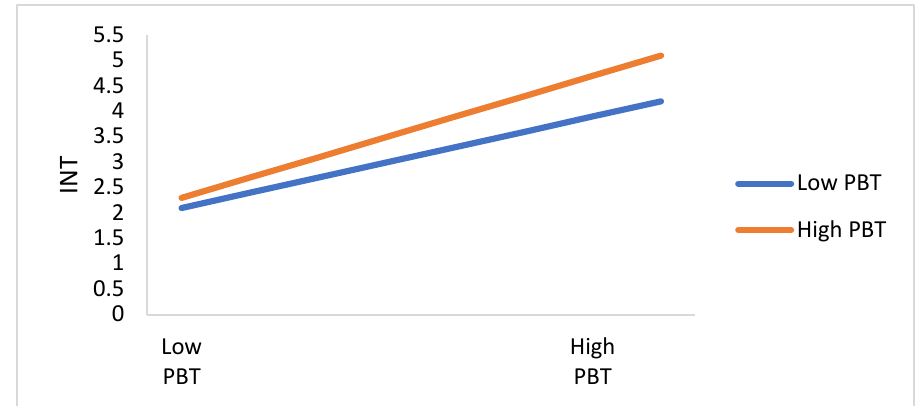
Figure 8. The plot of the moderating effect of health infodemics on the relationship between ATT and INT.